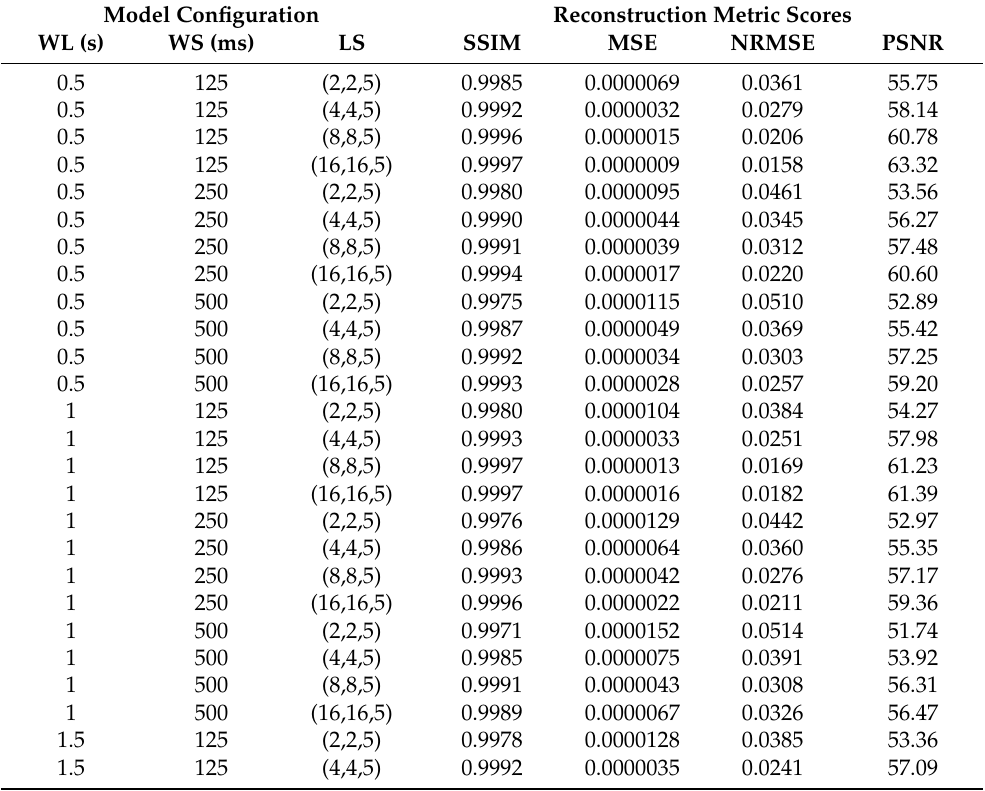
Table 2. Reconstruction scores from Structural Similarity Index Measure (SSIM), Mean Squared Error (MSE), Normalized Root Mean Squared Error (NRMSE), and Peak Signal-to-Noise Ratio (PSNR) for 48 models obtained with every possible window length (WL), window shift (WS), and latent space (LS)